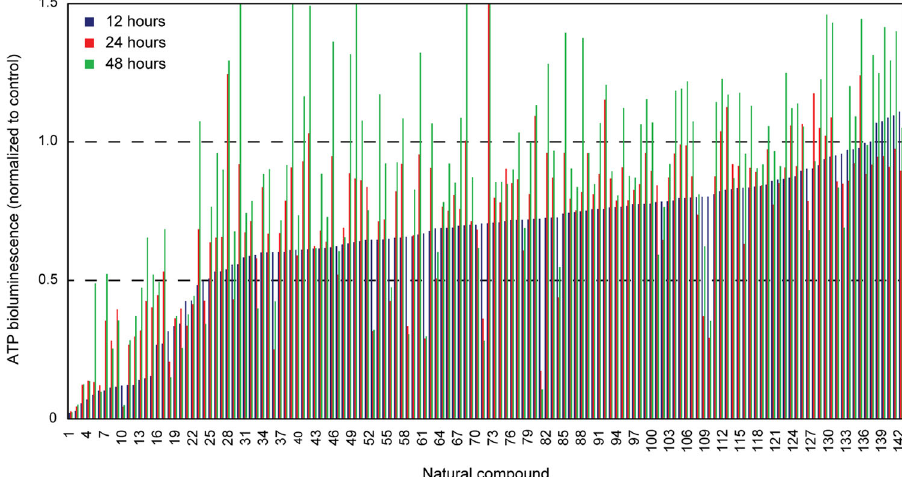
Fig. 1 Screening of a natural compound library. HMVP2 cell viability following treatment with a library of natural compounds was screened using the ATP bioluminescence assay. HMVP2 cells were treated for 12 ( blue ), 24 ( red ) and 48 h ( green ) with a library of natural compounds (single agent) at the dose of 5, 10 or 20 µM (only the latter dose is shown in the fi gure). Natural compounds are sorted according to increasing ATP bioluminescence values of the 12 h time-point (list of compounds is included in Supplementary Table 1). Relative ATP levels (ATP level in treated samples normalized by ATP level of untreated samples) as averages of four replicates are